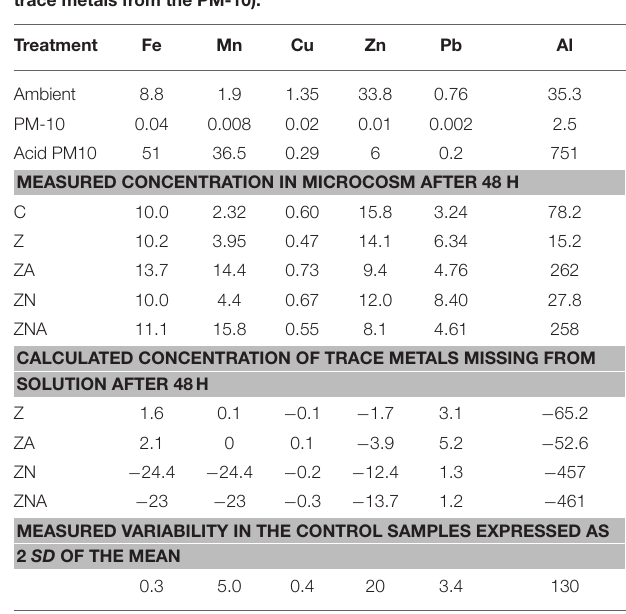
TABLE 3 | Concentration of trace metals in the ambient seawater before the start of the experiment, calculated concentration of trace metals added with the acidified (pH = 2) PM10 and the non-acidified PM10, measured concentration of trace metals in the microcosms after 48h, and calculated concentrations of trace metals missing from solution (calculated from the final concentration minus the control plus the added trace metals from the